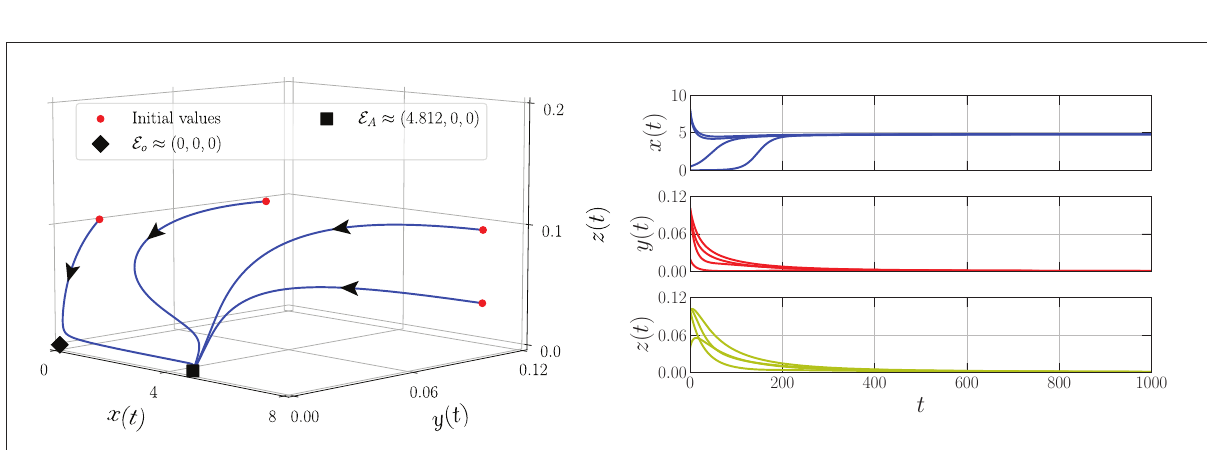
FIGURE2 Phase portrait and time series of the model (Equation 3) using parameter values: r = 0.1, K = 5, m = 0.25, c = 0.5, n = 0.01, β = 0.06, δ 1 = 0.05, δ 2 = 0.05, ω = 0.1, α = 0.9, and h = 0.02.